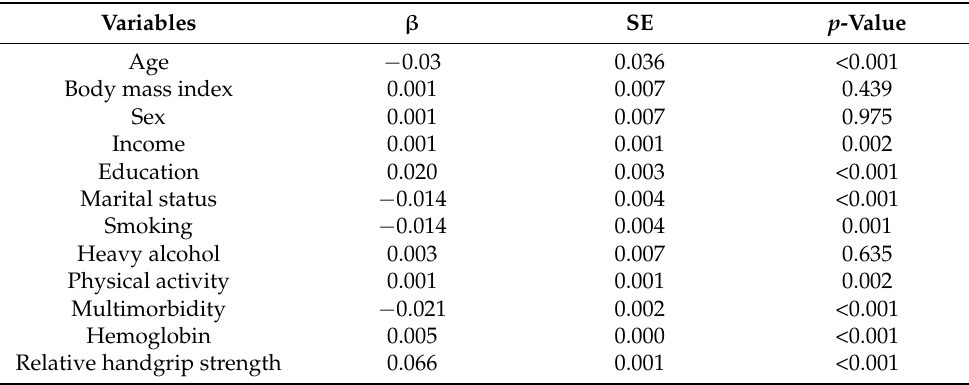
Table 3. Regression analyses for predictors of health-related quality of